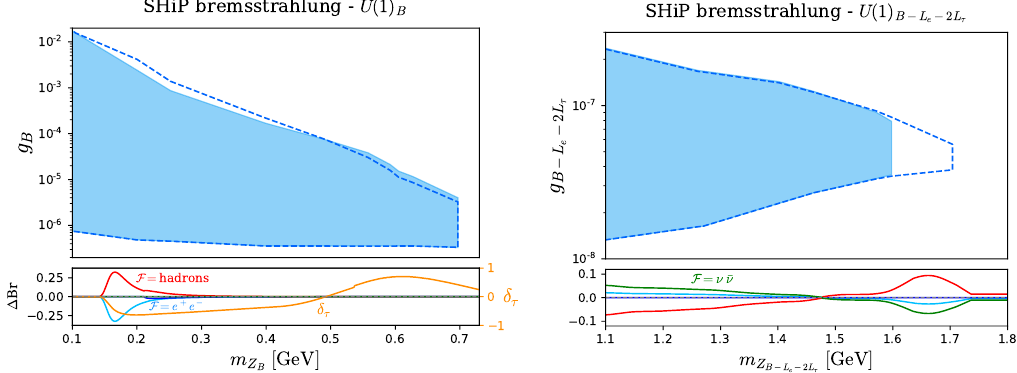
Figure 13 . Expected sensitivity for the B (left panel) and B − L e − 2 L τ (right panel) models for SHiP Bremsstrahlung production from our calculation (solid light blue) and DarkCast (dashed lines). In the bottom panels we show for each model the difference of the branching ratio between the two calculations, and for the B model the corresponding difference in lifetime ( δ stops earlier, at a mass of about 1.6 GeV, due to the increase of the hadronic final state modes above this